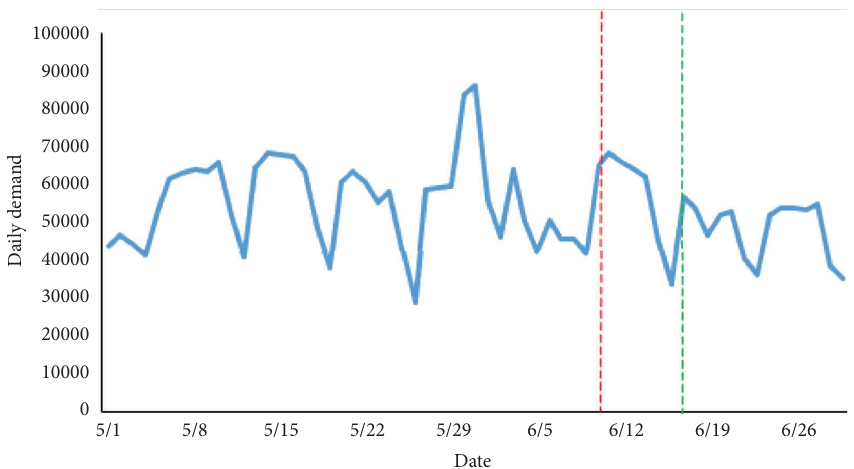
Figure 6: Te total demand of all girds on diferent